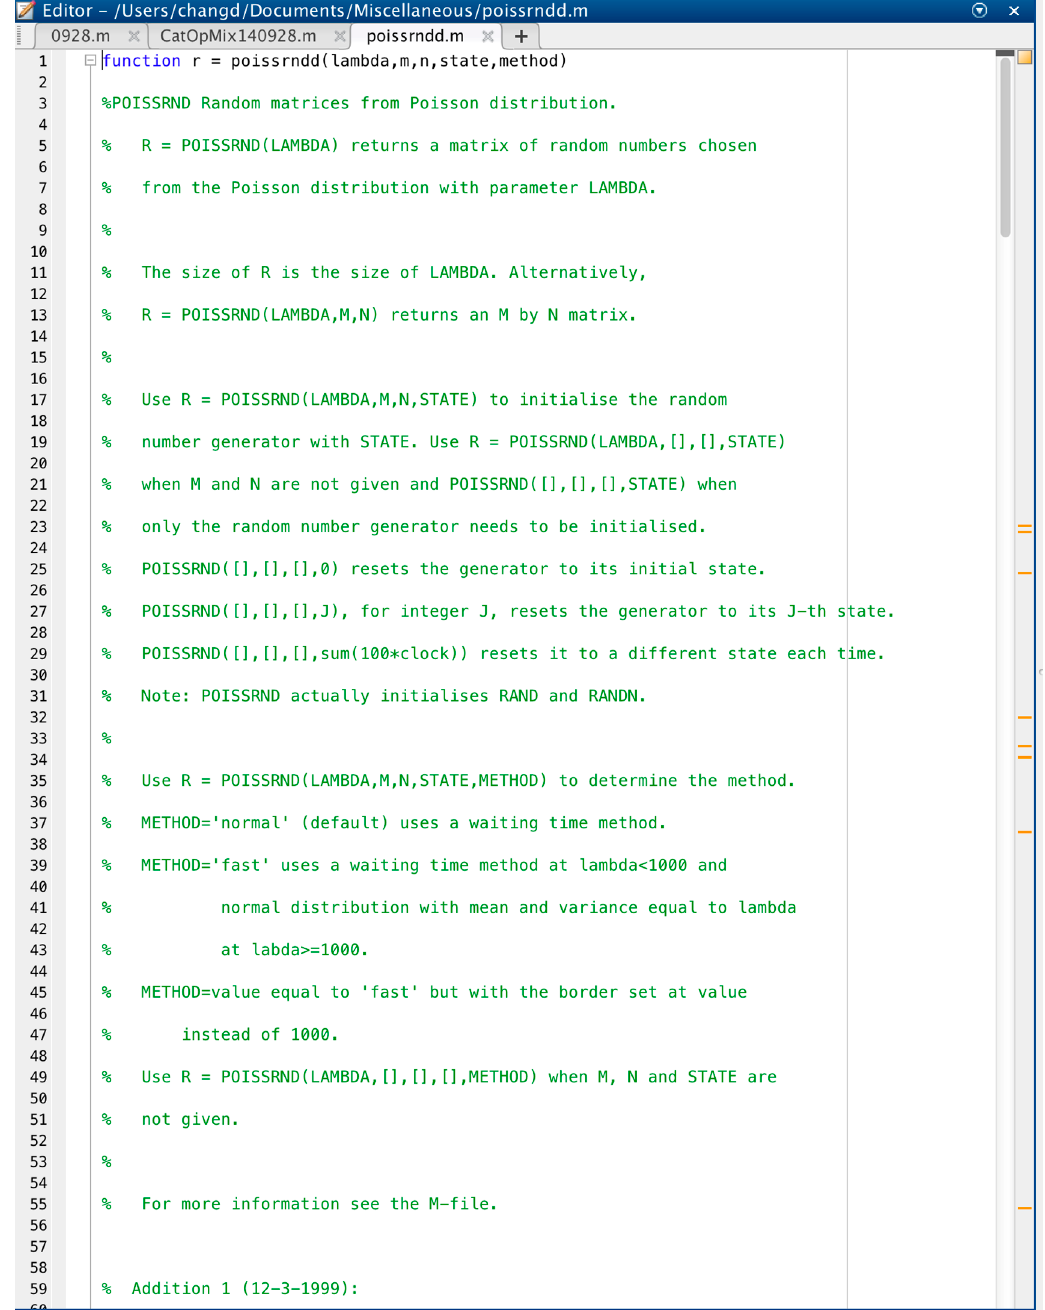
Figure A2. MATLAB code for the Poisson catastrophe arrival process.